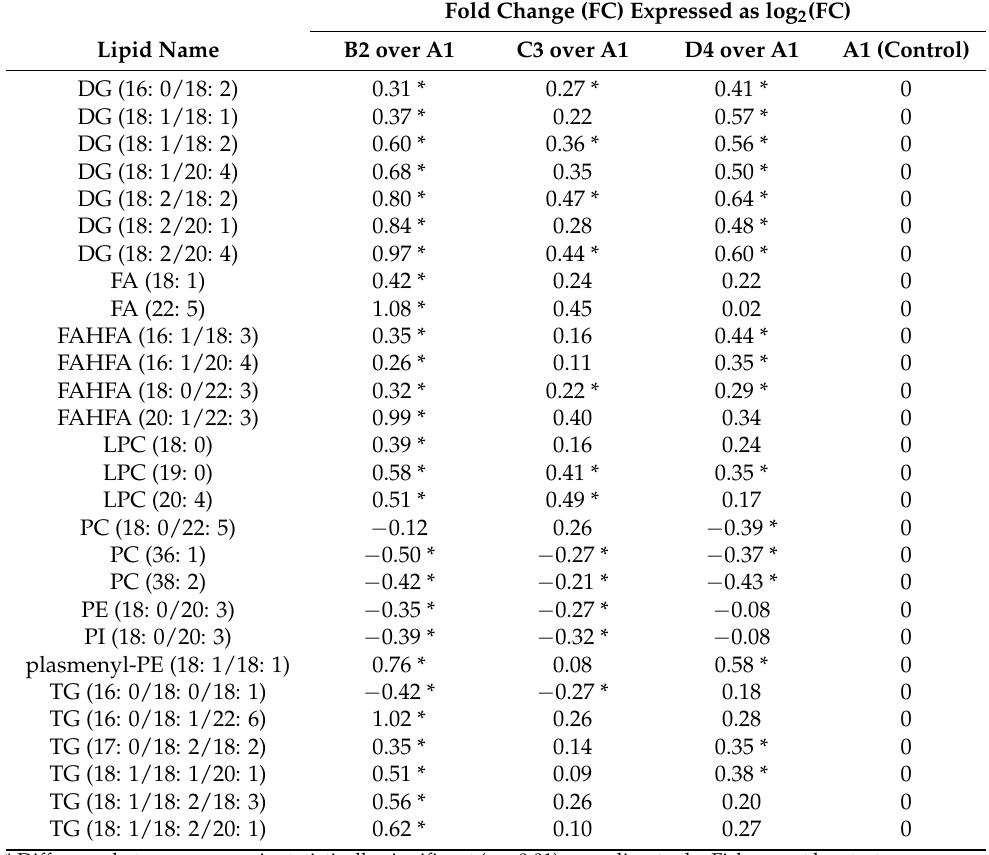
Table 3. The effect of mycotoxin and silymarin exposure on liver lipid content. Lipid species with OPLS-DA VIP score > 1 significantly contributing to the group separation in at least two binary comparisons (B2, C3 and D4 vs. control) are stated. The fold changes are expressed as log2(FC), so the breakpoint between downregulation and upregulation is equal to